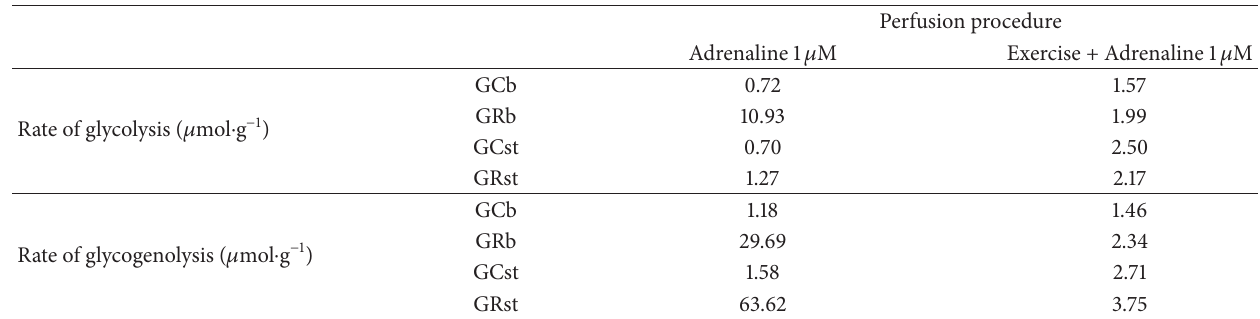
Table 5: Rates of glycolysis and glycogenolysis ∗